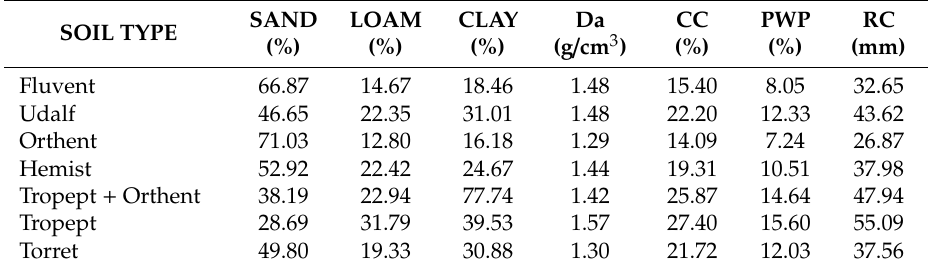
Table 2. Soil sample analysis, including mean values for soil texture, bulk density (BD), field capacity (CC), permanent wilting point (PWP) and water recitation capacity